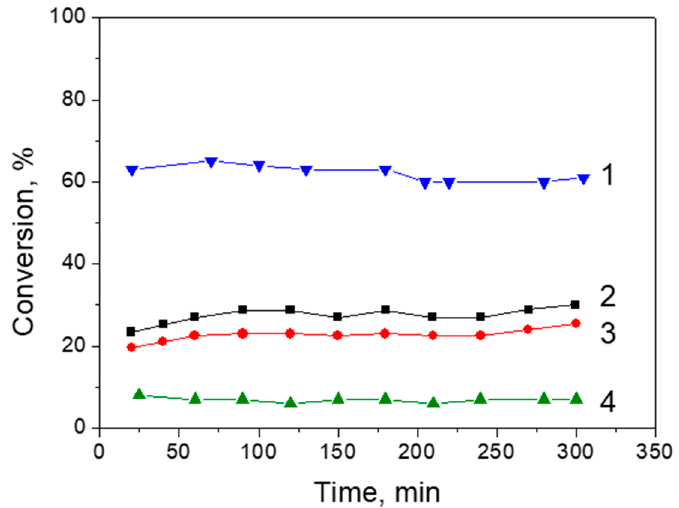
Figure 14. Dependence of the FA conversion on time over catalysts: 1% Pt/N-graphene (H 2 PtCl 6 ) (1); 1% Pt/N-graphene (Pt(NO 3 ) 4 ) (2); 0.4% Pt/N-graphene (H 2 PtCl 6 ) (3); 0.2% Pt/N-graphene (H 2 PtCl 6 ) (4). Reaction temperature: 150 °C.